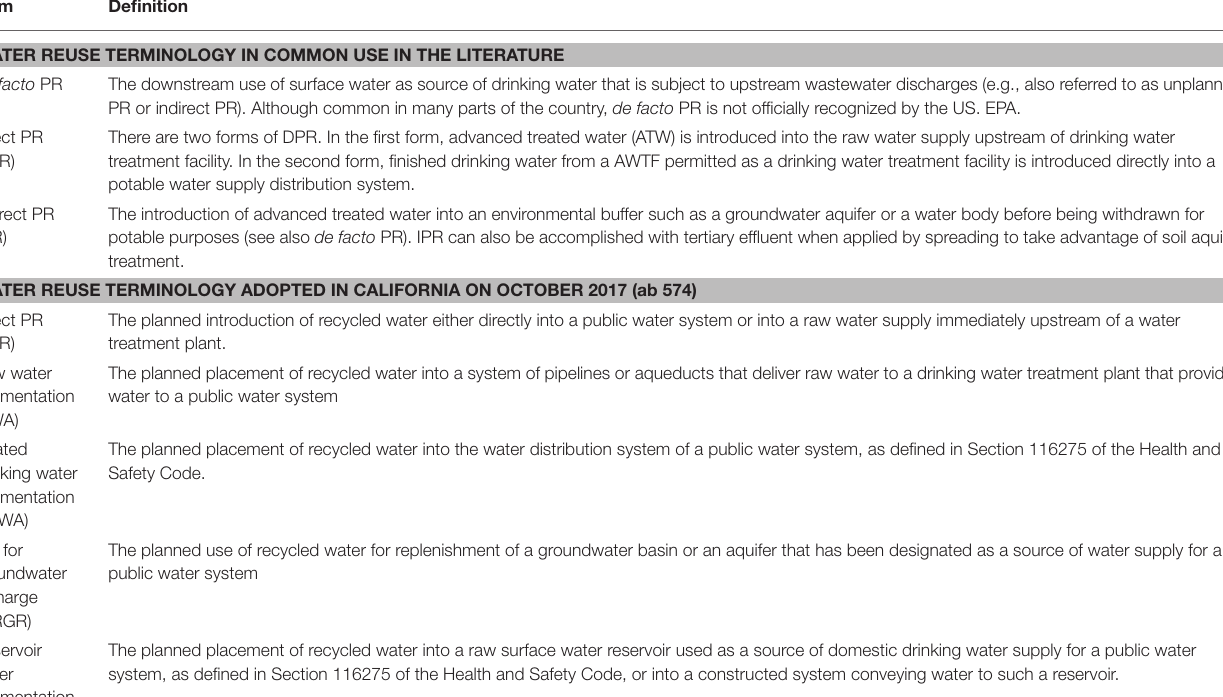
TABLE 5 | Terminology and definitions for potable